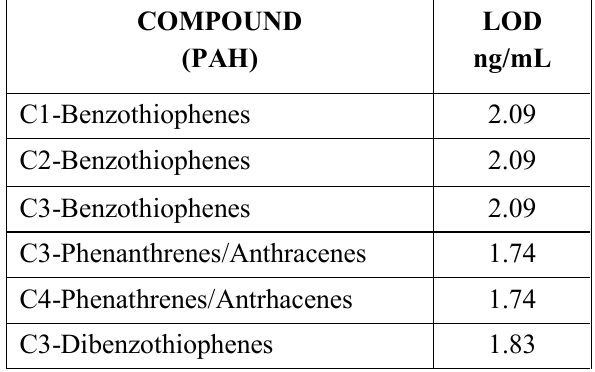
Table A1. Limits of Detection (LOD) for 19 Compounds that were not Measurable in 100% of Cord and Maternal Blood Specimens (N = 35 matched sample